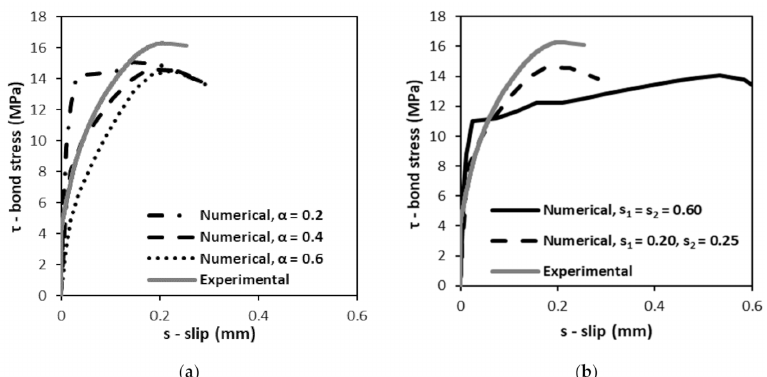
Figure 6. Influence of ( a ) the value of α and ( b ) the adoption of s 1 = s 2 = 0.60 in the numerical bond-slip curve of RC.